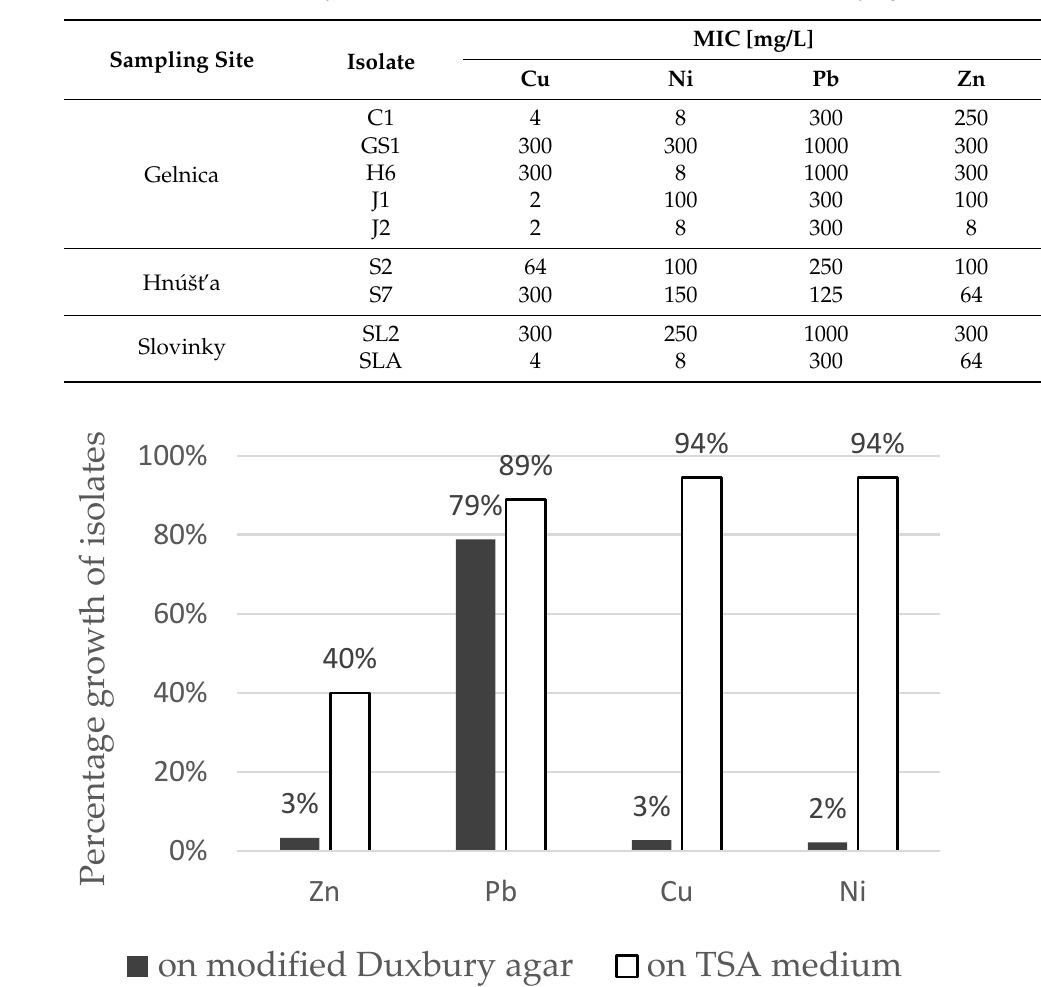
Table 2. Minimal inhibitory concentration (MIC) of isolates on modified Duxbury agar.